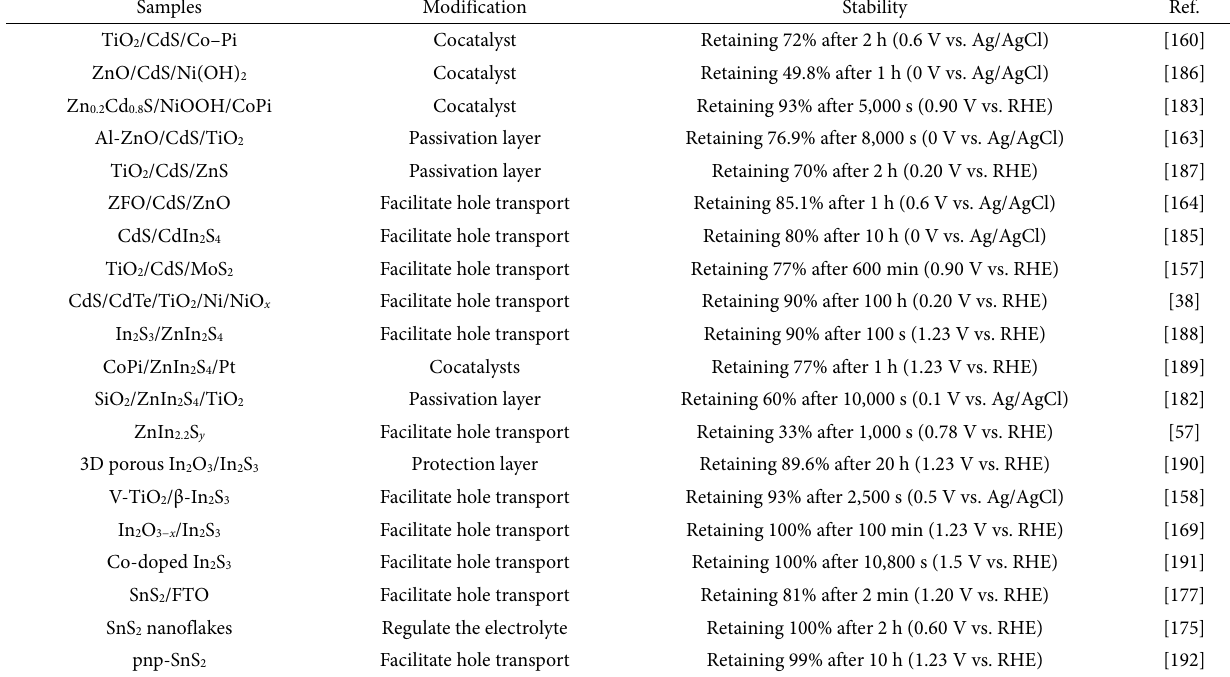
Table 2 The summary of stability research strategies for metal sulfides